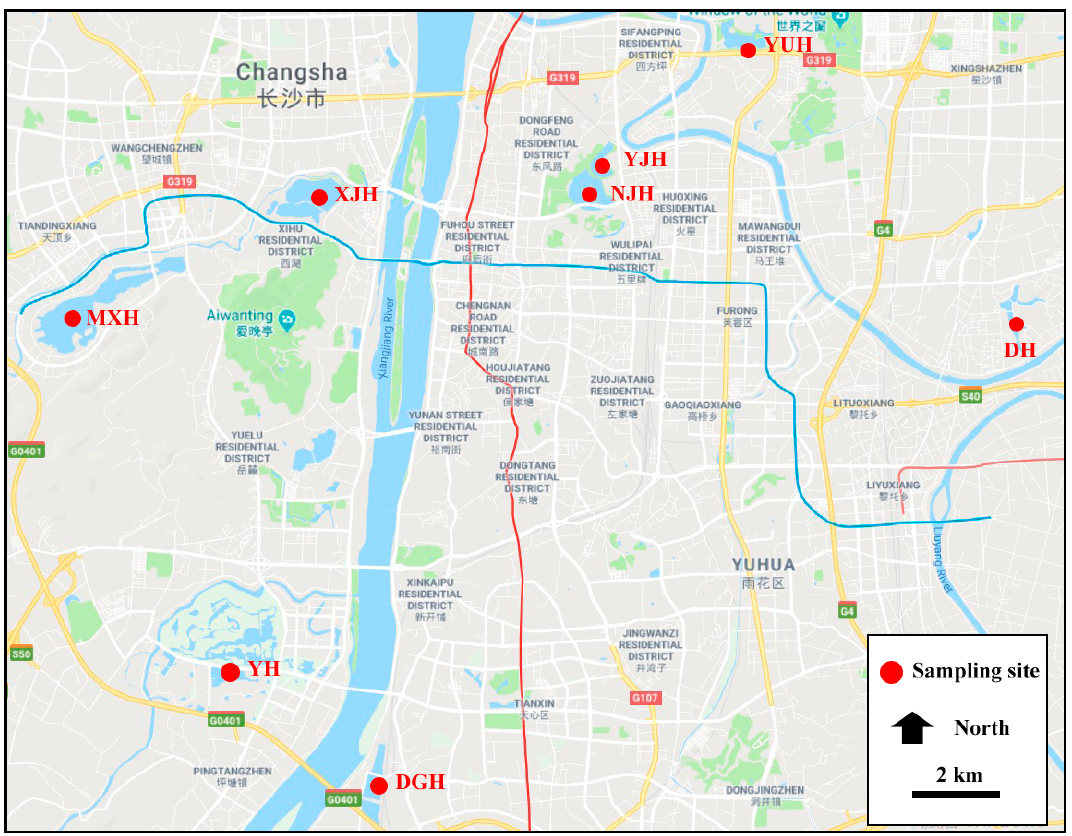
Figure 1. Geographic locations of sampling sites.